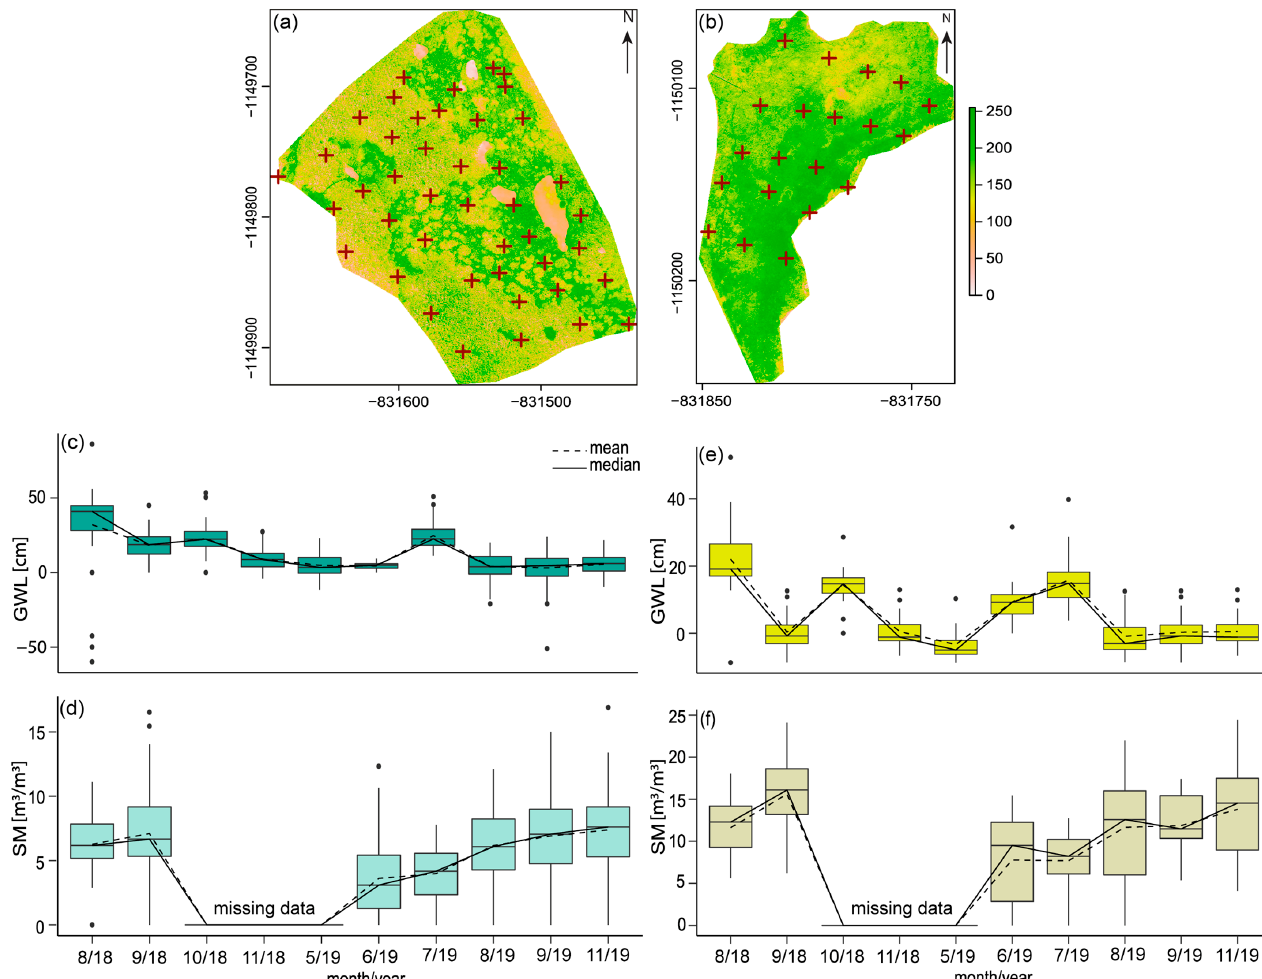
Figure 5. ( a ) Distributed sampling locations (water tubes) of GWL and SM at the UP (red markers), ( b ) distributed sampling locations of GWL and SM at the LP (red markers). The simulated prediction is based on sampled locations (in total, 63). ( c ) Boxplot of monthly sampled GWLs at tube positions with the mean and median distribution for the UP, and boxplot of monthly sampled SM at tube locations ( d ). ( e , f ) boxplots of sampled GWL and SM at tube locations for the LP. SM data are missing for the months September, November 2018, and May 2019 because usually there are no changes visible in SM and more or less comparable with September and October. In May, after the snow melts, the ground is saturated with water.